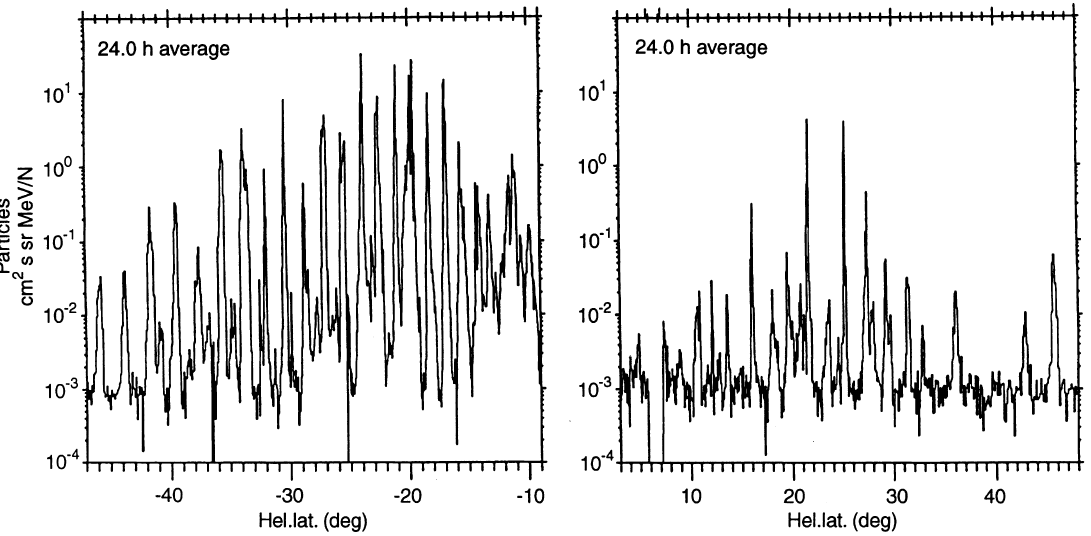
Fig. 3. Same data, plotted versus heliomagnetic latitude ( left panel, inbound; right panel , outbound)